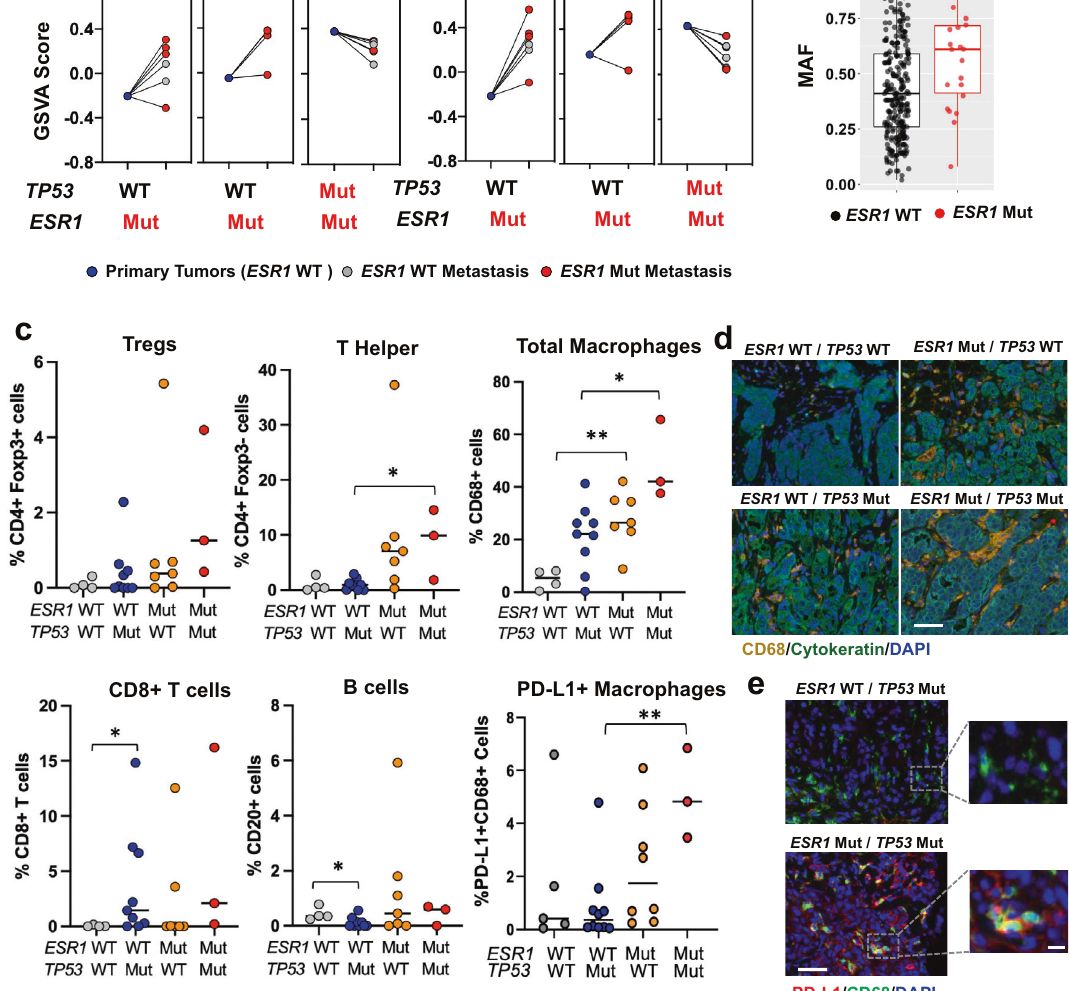
Fig. 5 Tumors with rare co-occurrence of TP53 and ESR1 mutations recapitulate the repression of ER activity by TP53 mutation and exhibit unique immune features. a Line plots showing the enrichment level alterations of general Estrogen Response Early signature (left panel) and TP53 -ER Signature (right panel) from primary to each metastatic tumor of the three individual autopsy patients. Mutations status on speci fi c specimens was indicated below. b Box plot showing the TP53 mutation allele frequencies between ESR1 WT and mutant tumors merged from MSKCC, POG570, MET500, INSERM, and METAMORPH cohorts ( ESR1 WT n = 266; ESR1 Mut n = 22). Box plots span the upper quartile (upper limit), median (center), and lower quartile (lower limit). Whiskers extend a maximum of 1.5X IQR. Whitney U test (two-sided) was used. (** p < 0.01). c Dot plots representing the quanti fi cation of the abundance of fi ve immune cell subtypes identi fi ed from multiplexed fl uorescent staining from UC cohorts. Samples were separated based on ESR1 and TP53 genotypes ( ESR1 WT/ TP53 WT n = 5; ESR1 WT/ TP53 Mut n = 10; ESR1 Mut/ TP53 WT n = 8; ESR1 Mut/ TP53 Mut n = 3). Numbers represent positive cells percentages of non-tumor cells (CK negative) from the fi eld except PD-L1/CD68 dual staining, where number represents positive cells percentage of all cells in the corresponding fi led. Median of each group was indicated. Whitney U test (two-sided) was applied for the comparisons between any of the two groups. (* p < 0.05; ** p < 0.01). d Representative images showing total macrophages in tumors with different ESR1 and TP53 genotypes from UC cohort. CD68 (orange) is part of a multiplex IF containing panel including CD4 (yellow), Foxp3 (green), CD8 (magenta), CD20 (red), cytokeratin (teal), and DAPI (blue). Images were taken under 20× magni fi cation. Scale bar = 50 μ m. e Representative images showing PD-L1 + macrophages dual-IF staining on tumors with TP53 mutation only and ESR1 / TP53 mutations. PD-L1 (red) and CD68 (green) were co-stained along with DAPI (blue). Images were taken under 20× magni fi cation. Speci fi c regions were further zoomed in to highlight target cells. Scale bar = 50 μ m (left panel) and 5 μ m (right